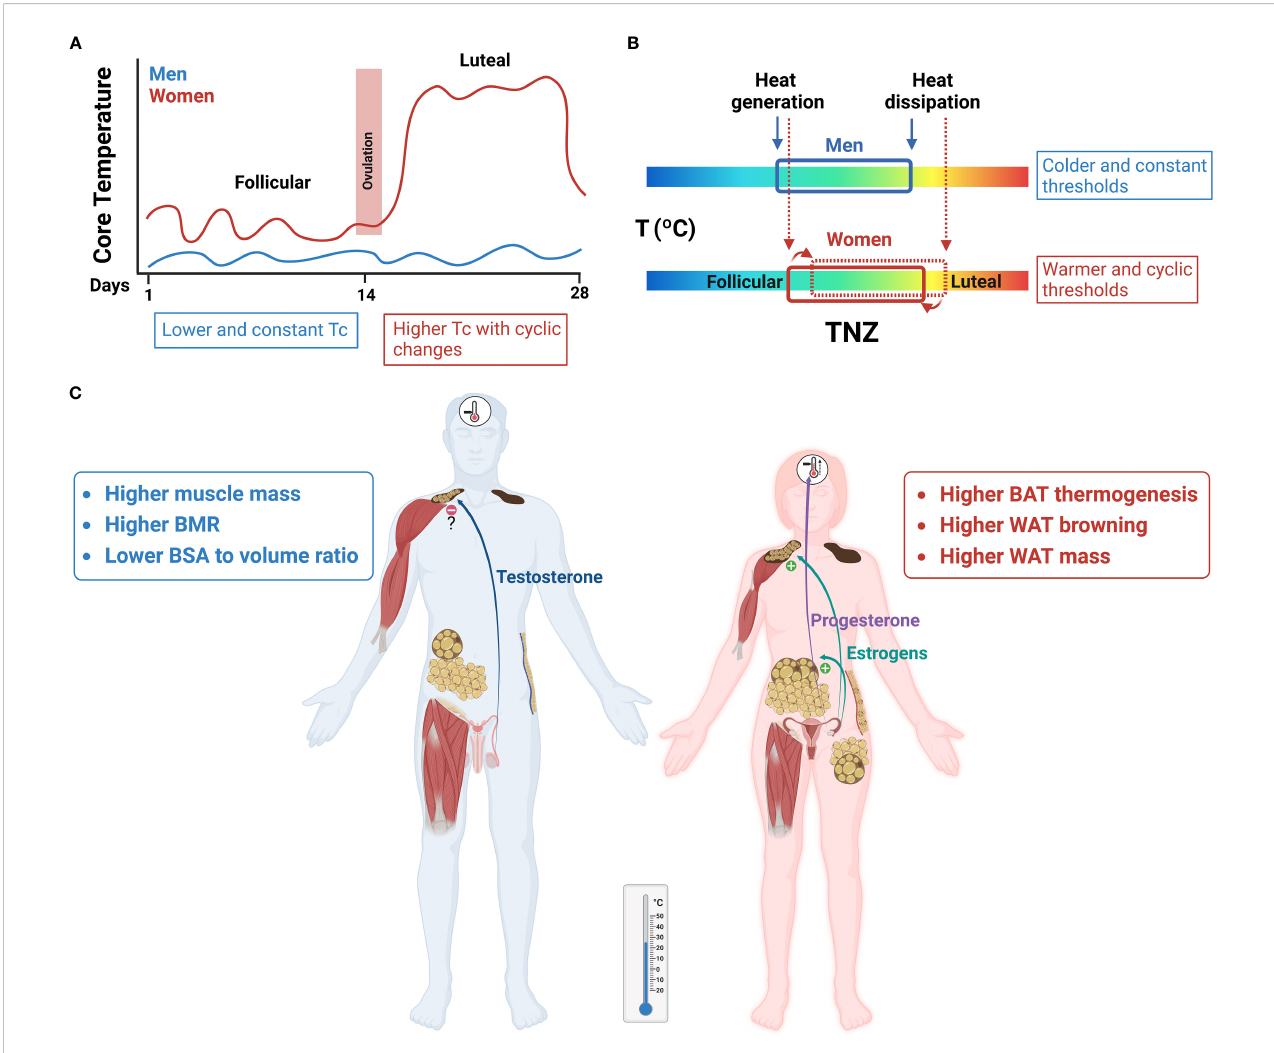
FIGURE 4 Sex differences in thermoregulation have an impact on energy homeostasis. Red and blue represent women and men, respectively. (A) Core temperature (Tc) levels are higher in women than in men and vary across the ovarian cycle, associated to changes in progesterone:estrogens circulating concentrations. In the luteal phase there is an increase of ≈ 0.5 °C, when compared to the follicular phase. (B) A representation of the thermoneutral zone (TNZ) in both sexes. The increase of Tc levels in women is a regulated process, as shown by the shifts in thermoregulatory thresholds of effector mechanisms toward the defense of this higher temperature. Accordingly, cold output mechanisms will be activated at higher ambient temperatures in women than in men. (C) At mild temperatures a greater BAT and WAT browning thermogenesis will be observed in women compared to men, which will increase energy expenditure. Sexual hormones play a central role in these sex differences, with estrogens as principal stimulators of BAT activity and WAT browning and regulators of vasomotor control, and progesterone as a thermogenic signal acting at the set-point(s) in the